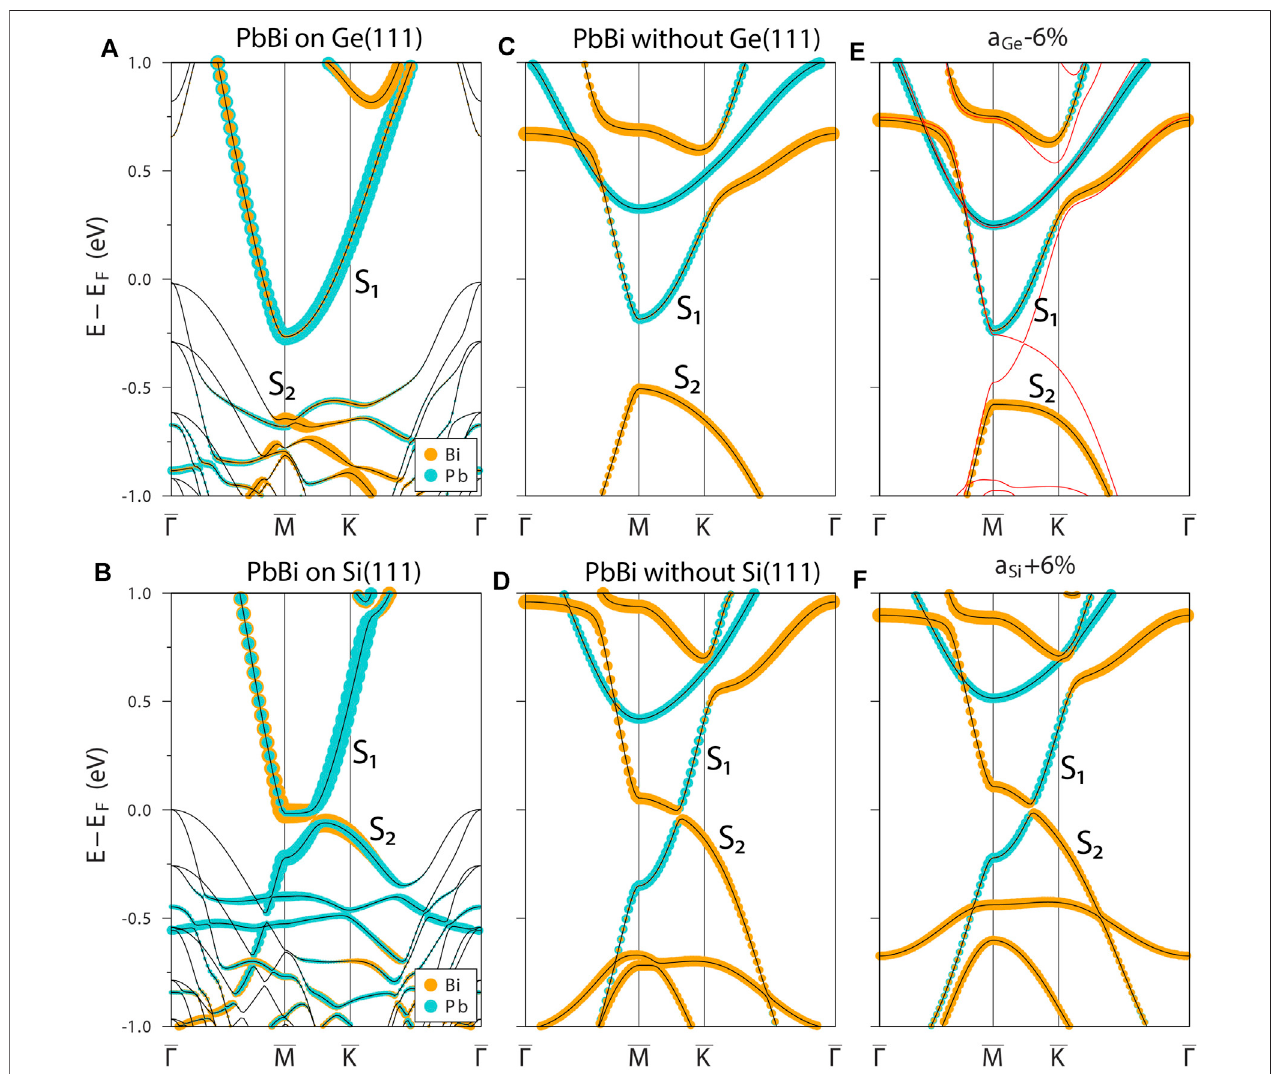
FIGURE4| Electronicbandstructureof2×2-PbBiphasesupportedbygermanium (A) andsilicon (B) substrates.Panels (C,D) showthespectraforfree-standing PbBi layer withgermanium and silicon lattice constants, respectfully.Panels (E,F) display the impactofcompressive/tensile strain on electronic structure ofpristine free- standingPbBilayer.Allspectraarecalculatedinelements-projected non-relativisticformalonghigh-symmetrydirectionsofthe2×2SBZshown intheinsetatthepanel (C) . The elemental characters of the bands are shown by colored circles.